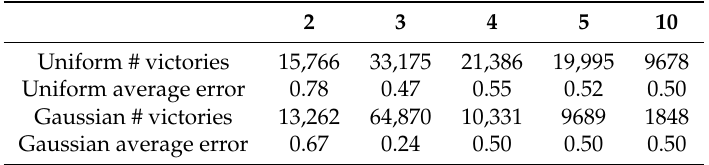
Table 6. Number of times each value of k produces minimal error and average error values, over 100,000 items generated according to both models with rounding compression.